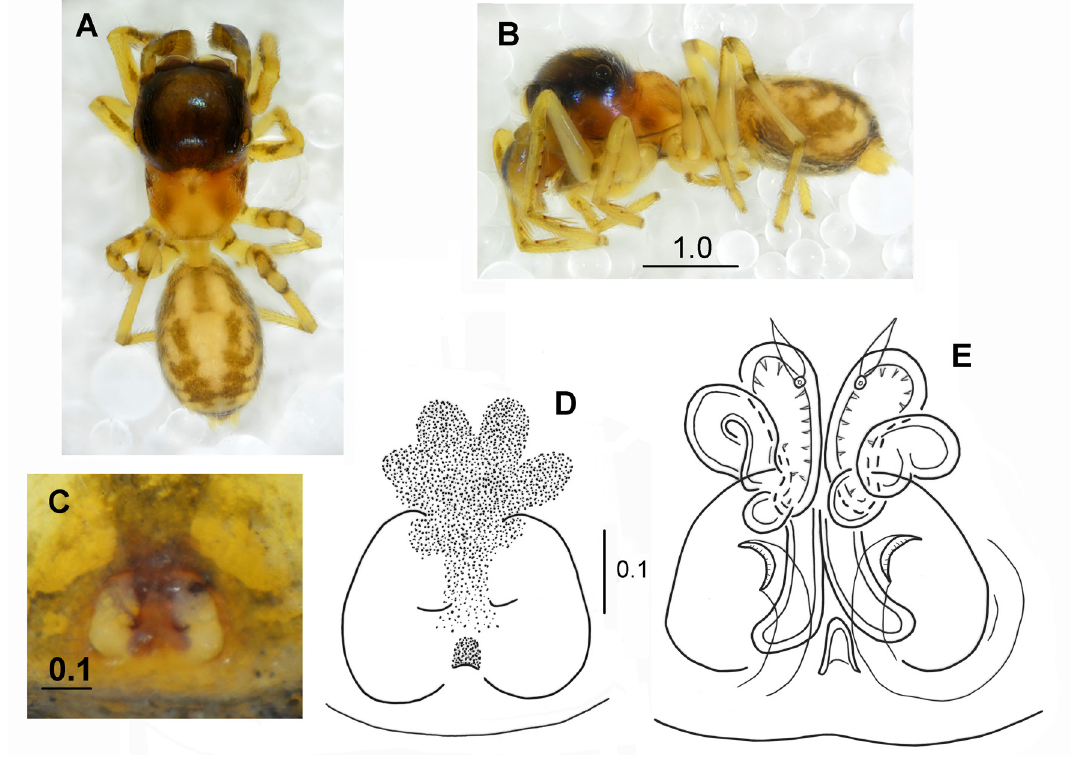
Fig. 39. Myrmarachne galea sp. nov., paratype, ♀ (MNHN). A . Habitus, dorsal view. B . Habitus, lateral view. C–D . Epigyne. E . Internal structure of